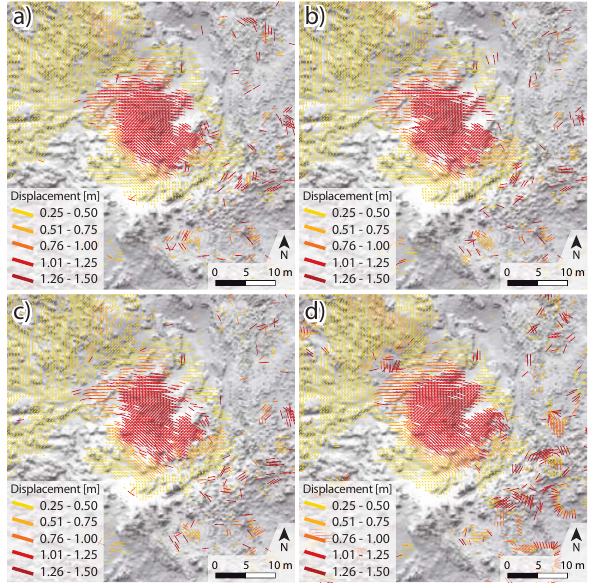
Figure 13. Detailed view of the displacement vectors greater than 0.25m resulting from the image correlation of the shaded reliefs based on the rules ’maximum geometric curvature’ (a), ’maximum planarity’ (b), ’minimum elevation’ (c) and ’sensor correspondence’